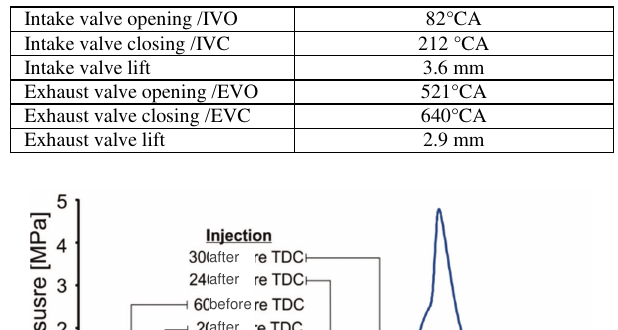
Table 2. Valve timings and lifts